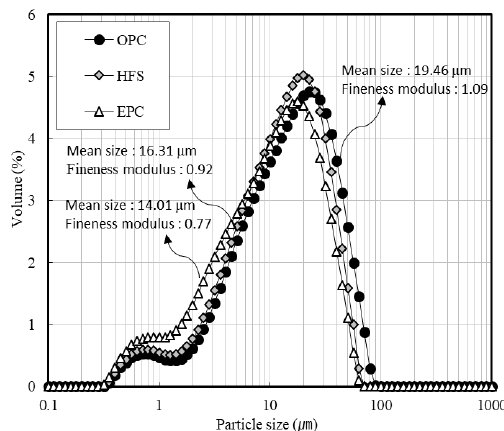
Figure 5. Particle size distribution of ordinary Portland cement (OPC), high fineness and SO 3 ordinary Portland cement (HSPC), and early Portland cement (EPC).